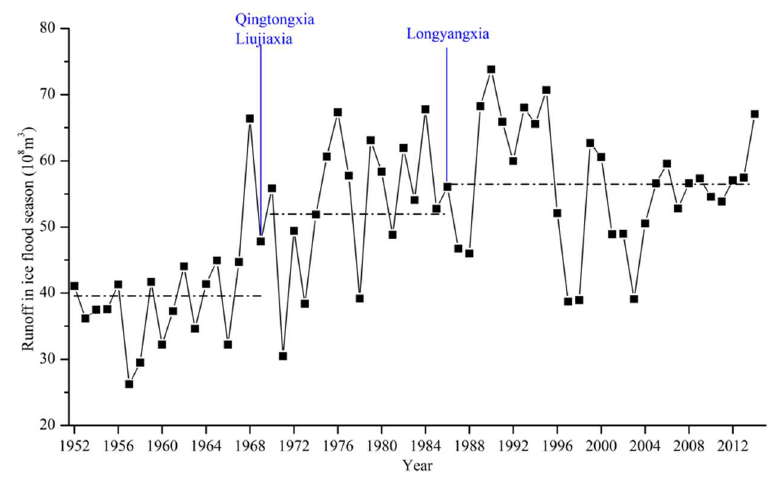
Figure 3. Variation of the annual runoff recorded at Qingtongxia station during the ice jam flooding seasons.